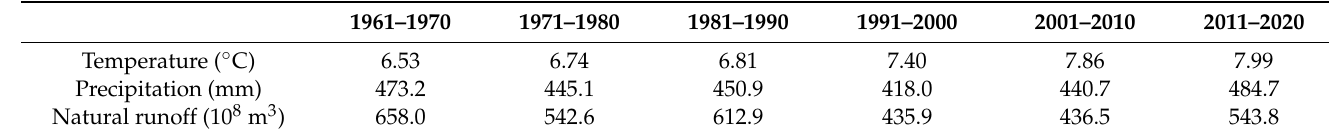
Table 1. Statistics of annual mean temperature, annual total precipitation, and natural runoff from